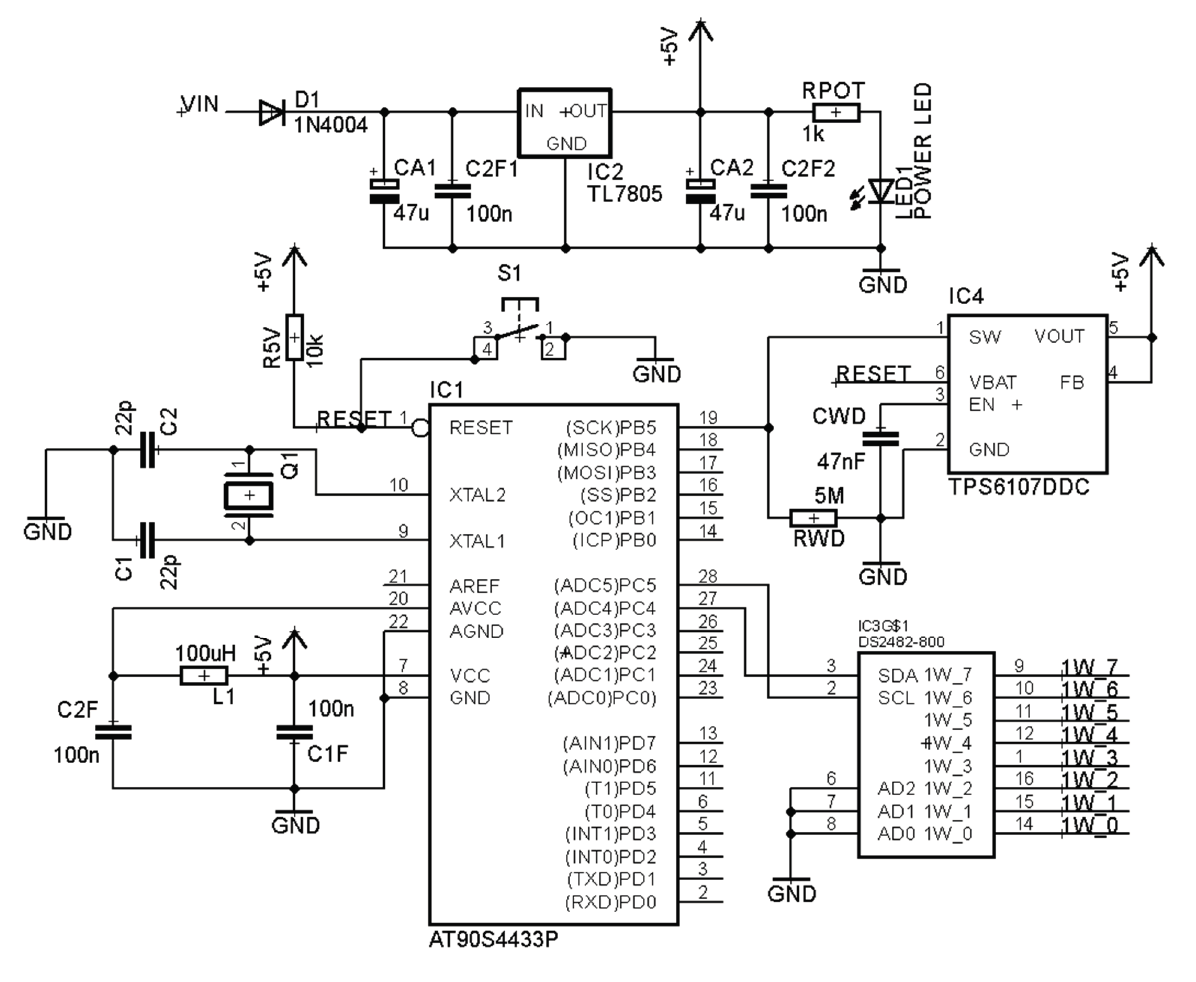
Figure 3. Slave Schematic Final